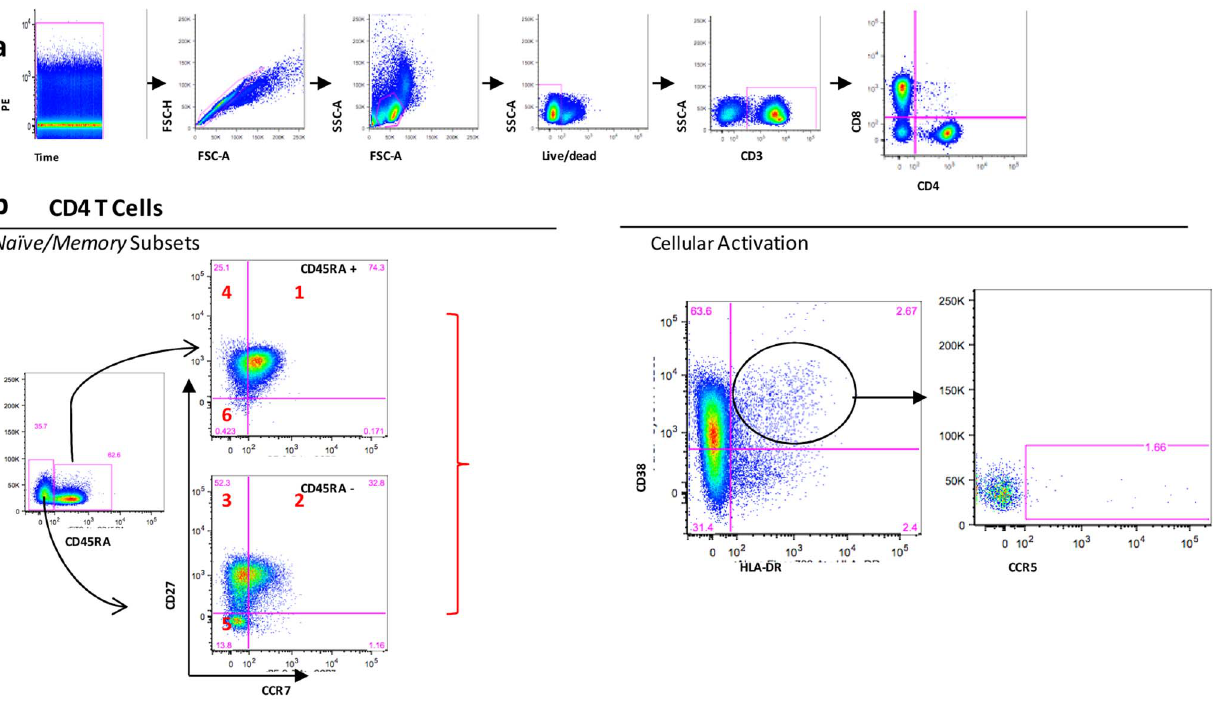
Fig. 1. Strategy of analysis of Flow Cytometer data from one representative experiment with PBMC samples of HIV infected children. (A) Were used high Quality Parameters: (Time x PE-to check laser status; Singlets-to exclude the doublets cells; SSC x FSC- to choose lymphocytes subset; Live/ Dead-to exclude the dead cells; gate SSC x CD3- to chose T lymphocytes and gate CD4 x CD8- to separate in CD4 and CD8 T subsets, then b Naı¨ve/ Memory subsets and cellular activation were evaluated in CD4 T Cells and CD8 T Cells, (B) Naı¨ve/Memory CD4 + Subsets were classified through differentiated expression of three markers (CD45RA, CD27 and CCR7): 1- Naı¨ve (CD45RA + CD27 + CCR7 + ); 2- Central Memory (CD45RA 2 CD27 + CCR7 + ); 3- Transitory Memory (CD45RA 2 CD27 + CCR7 2 ); 4- Intermediary Memory (CD45RA + CD27 + CCR7 2 ); 5- Effector Memory (CD45RA 2 CD27 2 CCR7 2 ); 6- Effector (CD45RA + CD27 2 CCR7 2 ); Cellular Activation were characterized through expression of CD38, HLA-DR and CCR5.